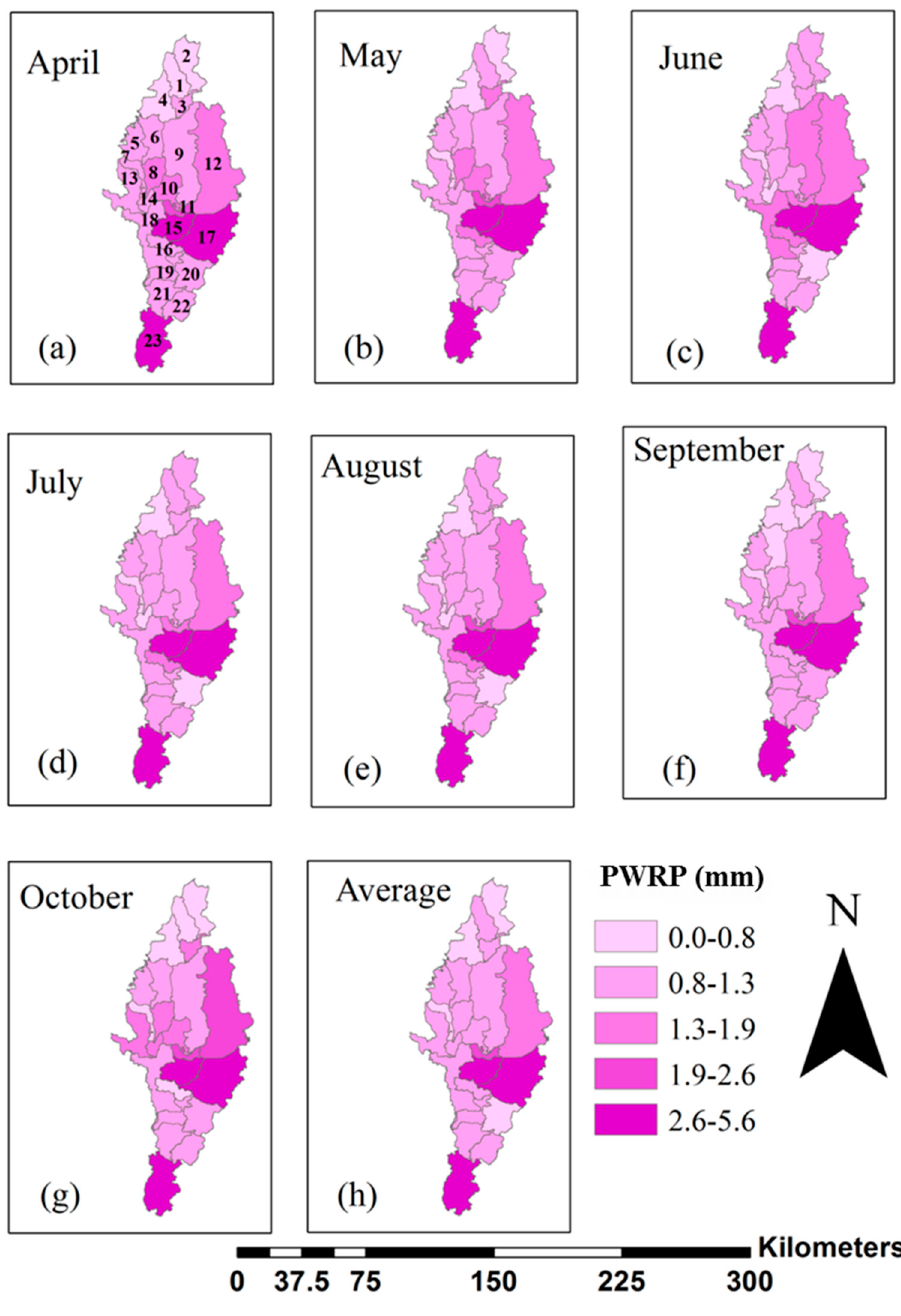
Figure 4. Spatial distribution of simulated weekly pond surface water resources potential (PWRP) in each sub-basin during the growing season between 2000 and 2016. * PWRP is defined as: PWRP = PWR − PE; PWR is pond water resources; PE is pond water